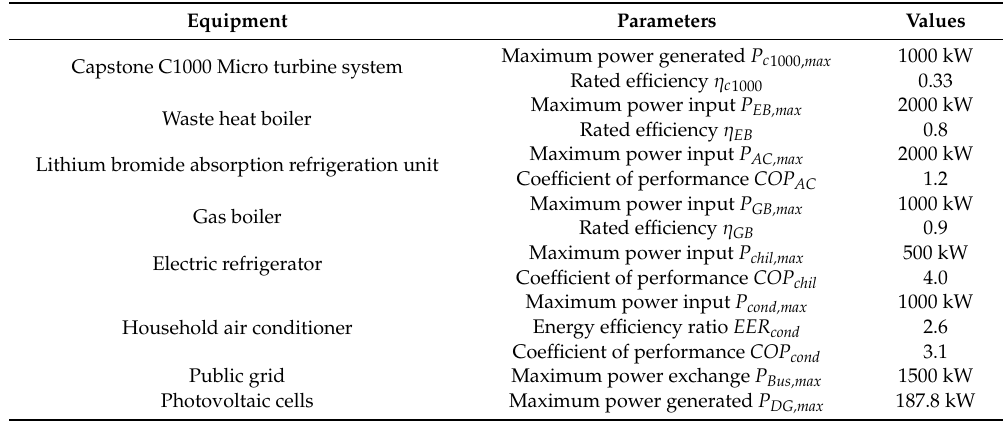
Table 1. The parameters of energy supply equipment.